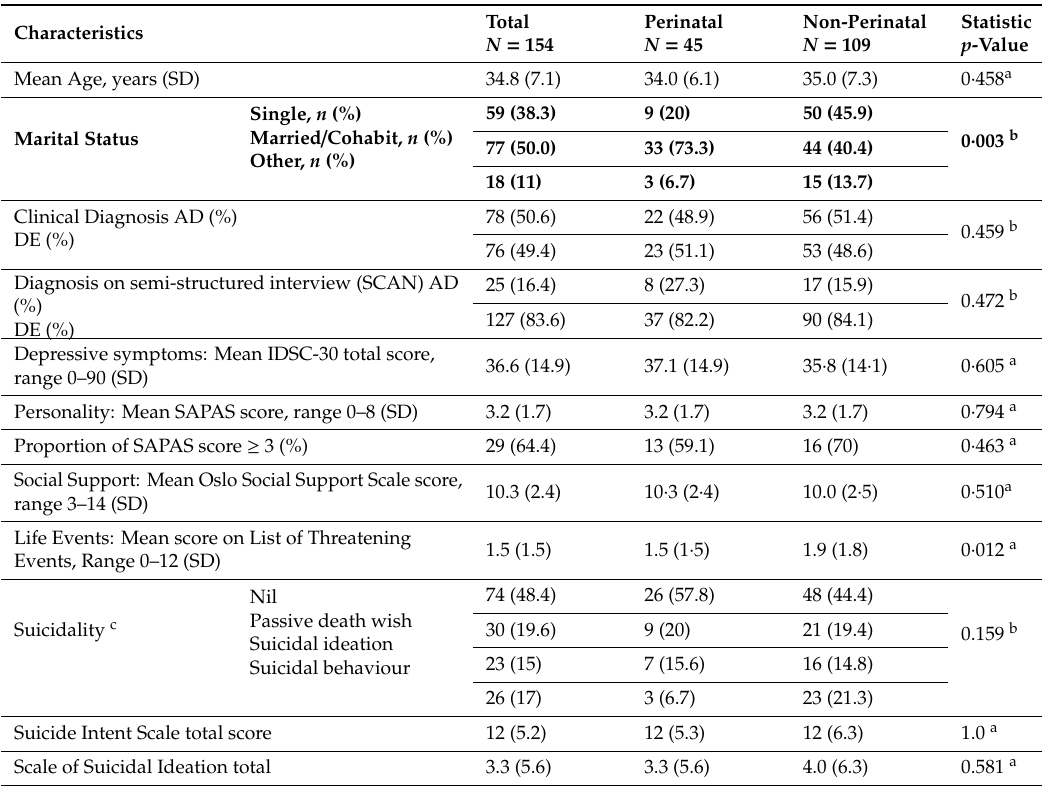
Table 2. Demographic and clinical characteristics of the study population—women recruited in the perinatal period (pregnancy to 12 months following birth) and a comparison group matched for age gender and